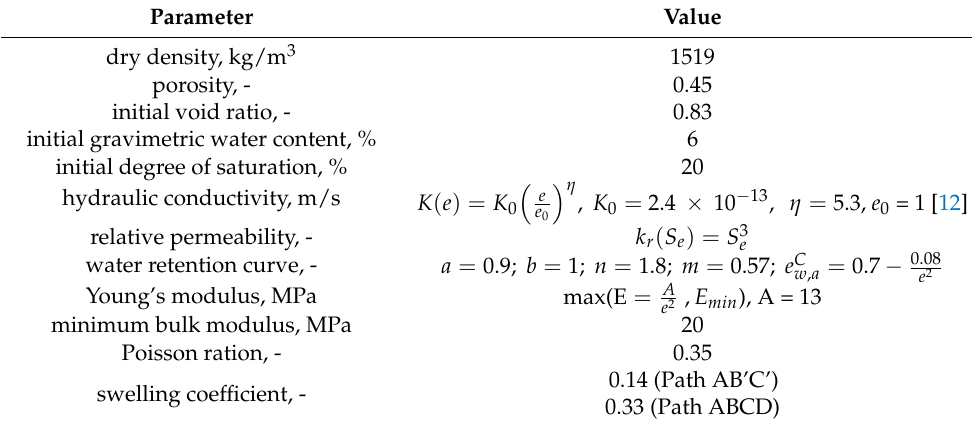
Table 2. Parameters used for the